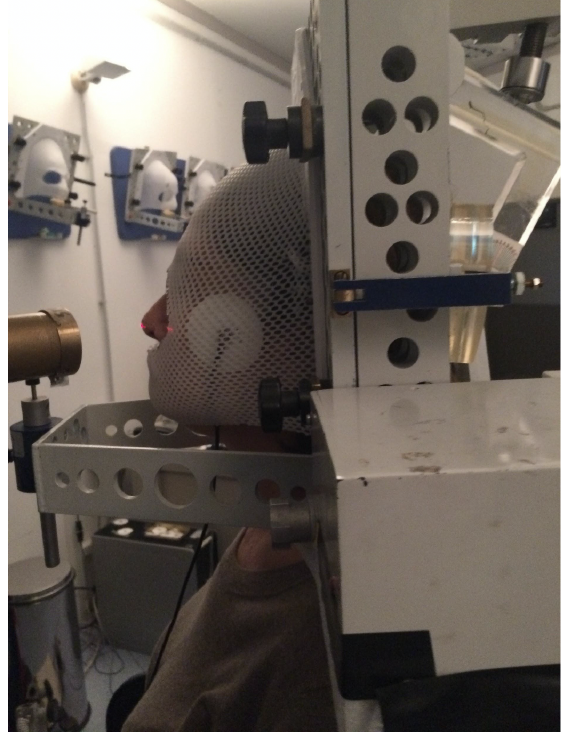
Figure 3. A patient just before the proton therapy session with the electrode system positioned under the thermoplastic